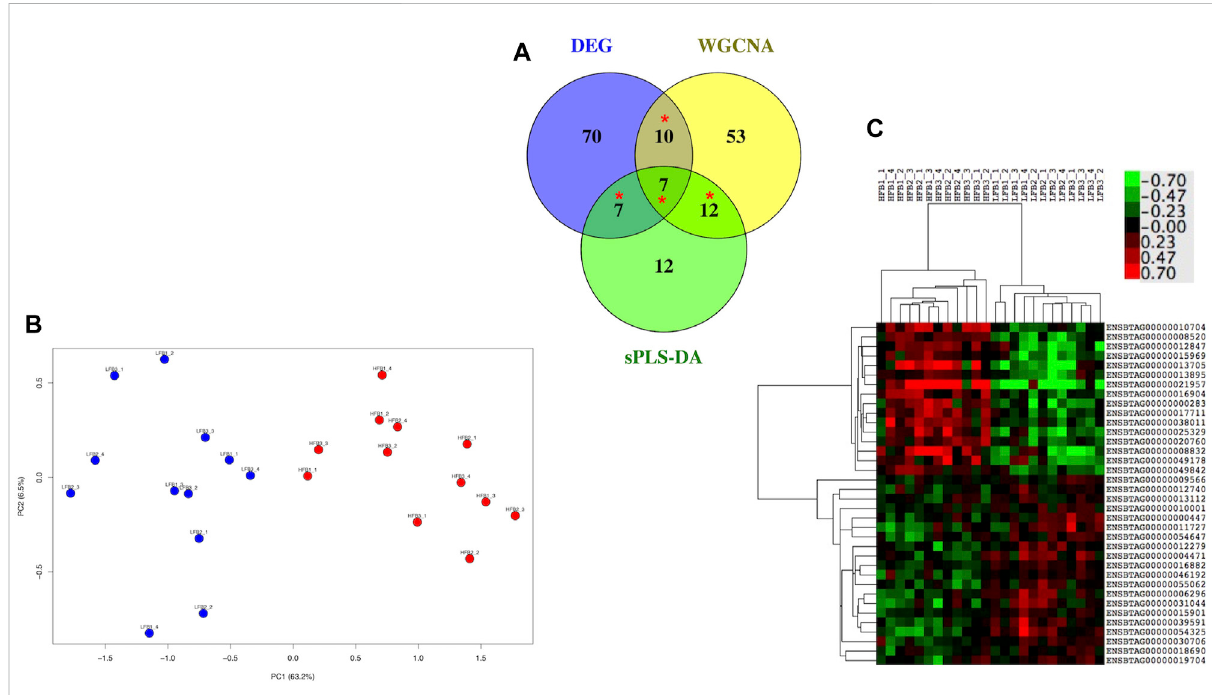
FIGURE 9 Mostrelevantgenesrelatedto highfertility (HF)orlow fertility(LF)groups determined thoughamachine learning approach.Geneswith atleast 50% of AUC to predict the group were retained from the genes selected by three methods (DEG, WGCNA, sPLS-DA; see Figure 1). (A) genes were compared in a Venn Diagram to identify 36 most relevant genes (*). (B) Principal component analysis of the HF and LF samples plotted according to the expression of the 36 genes; (C) Hierarchical clustering and heat map of the 36 genes. RNAseq data from endometrial explants exposed to a Day 15 conceptus from a HF or LF